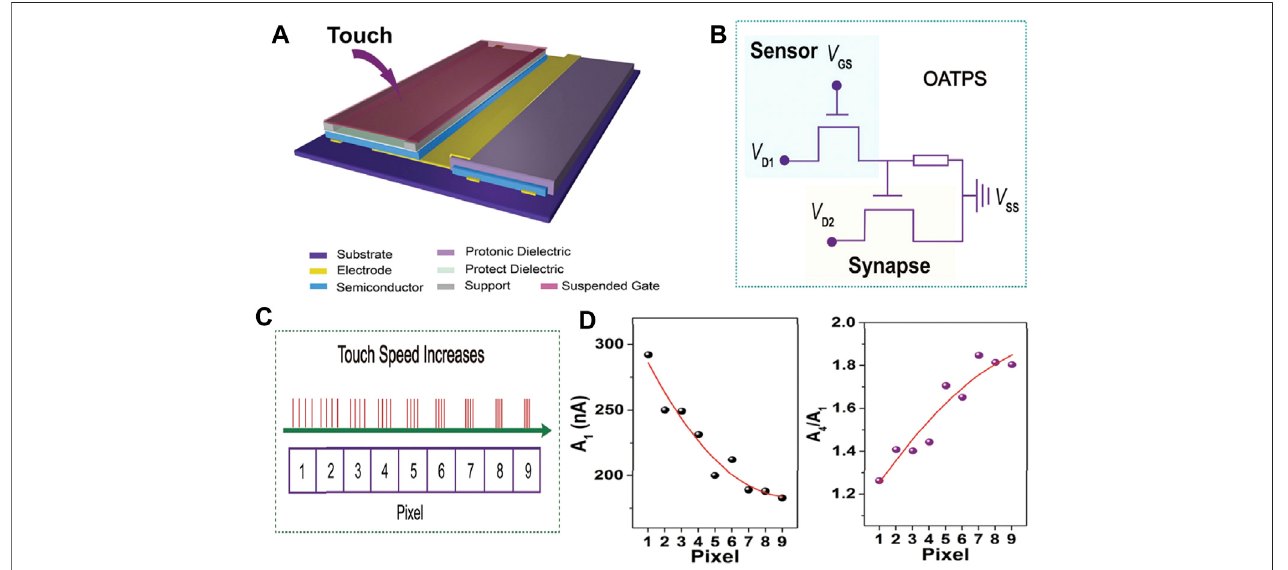
FIGURE5 | (A) Schematic illustration of the DOT-TPS. (B) Equivalent electrical circuit of the DOT-TPS. (C) Four continuous and repeated touch cycles applied to the nine pixel. (D) The EPSC (A 1 ) and the gain A 4 /A 1 for each pixel (adapted from Zang et al., 2017).